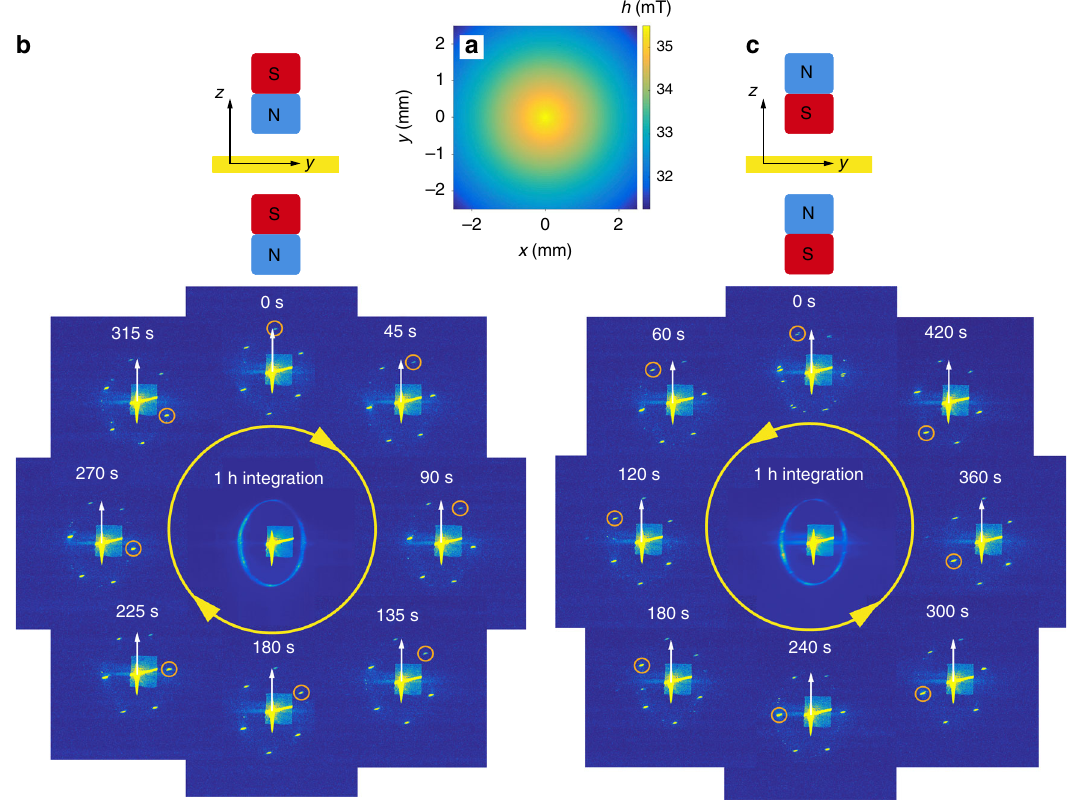
Fig. 3 Skyrmion lattice rotation in magnetic fi eld gradients. a The static external magnetic fi eld B ¼ ½ 0 ; 0 ; h ð x ; y Þ(cid:4) is applied along the z -direction. The lateral distribution of h ( x , y ) is shown, in which the fi eld is maximum in the centre and decreases outwards, leading to a radial fi eld gradient in the plane. The sample is shown in yellow. b CCD camera snapshots taken at the indicated times during the fi eld gradient-induced skyrmion lattice rotation. The rotation sense is clockwise. To better illustrate the motion, one of the magnetic satellites is marked by an orange circle, in comparison to the reference white arrow that is locked in the 12 o ’ clock direction. The integrated camera image over one hour is shown in the middle. c Anticlockwise skyrmion rotation obtained with the magnetic fi eld applied in the opposite